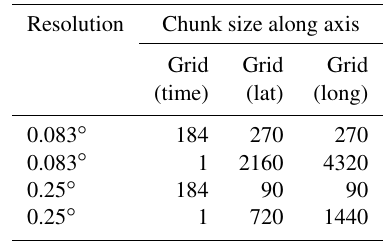
Table 2. Resolutions and chunkings of the currently implemented global Earth system data cube per variable. Here, the cubes with chunk size 1 in the time coordinate are optimized for accessing global maps at a time, while the other cubes are more suited for processing time series or regional subsets of the data cube. The cubes are currently hosted on the Object Storage Service by the Open Telecom Cloud under https://obs.eu-de.otc.t-systems.com/ obs-esdc-v2.0.0/ (last access: 21 February 2020) (state: Septem- ber